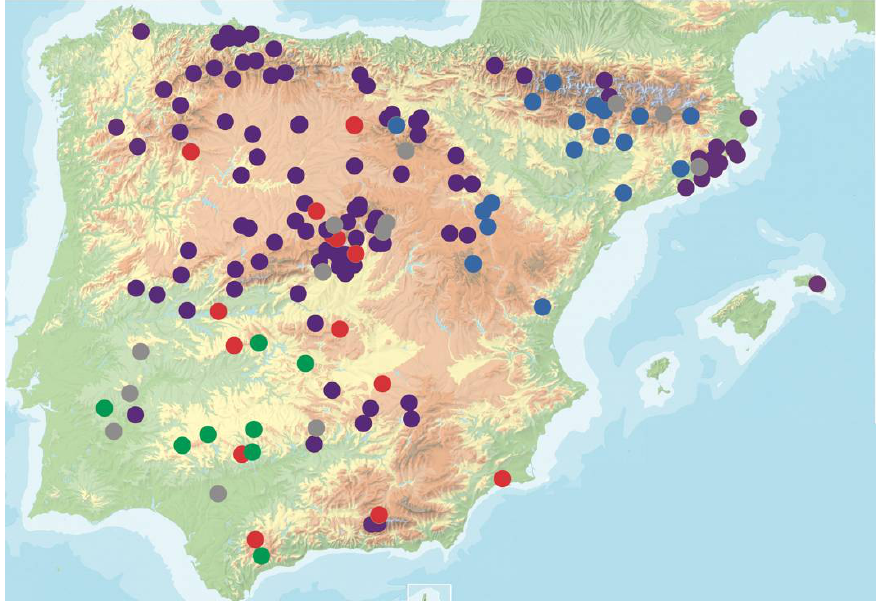
Figure 1. Geographic distribution of Arabidopsis thaliana genotypes analyzed in this study. Circles indicate population locations. Colors indicate genetic groups as defined in [39] (group 1: purple, group 2: blue; group 3: red; group 4: green). Grey dots indicate genotypes eliminated from the analysis.